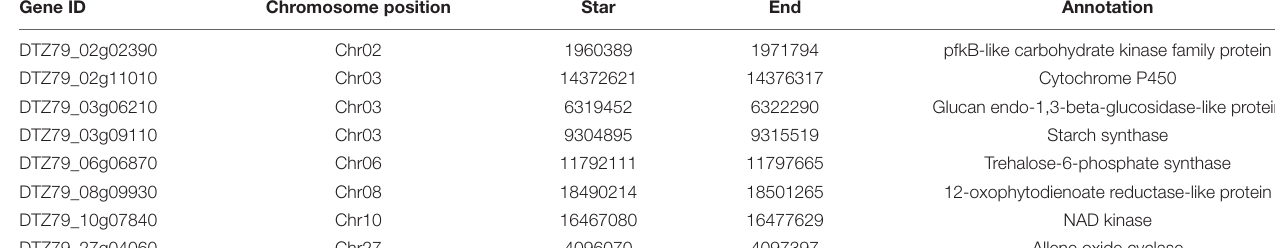
TABLE 2 | Functional annotation of eight selected genes.